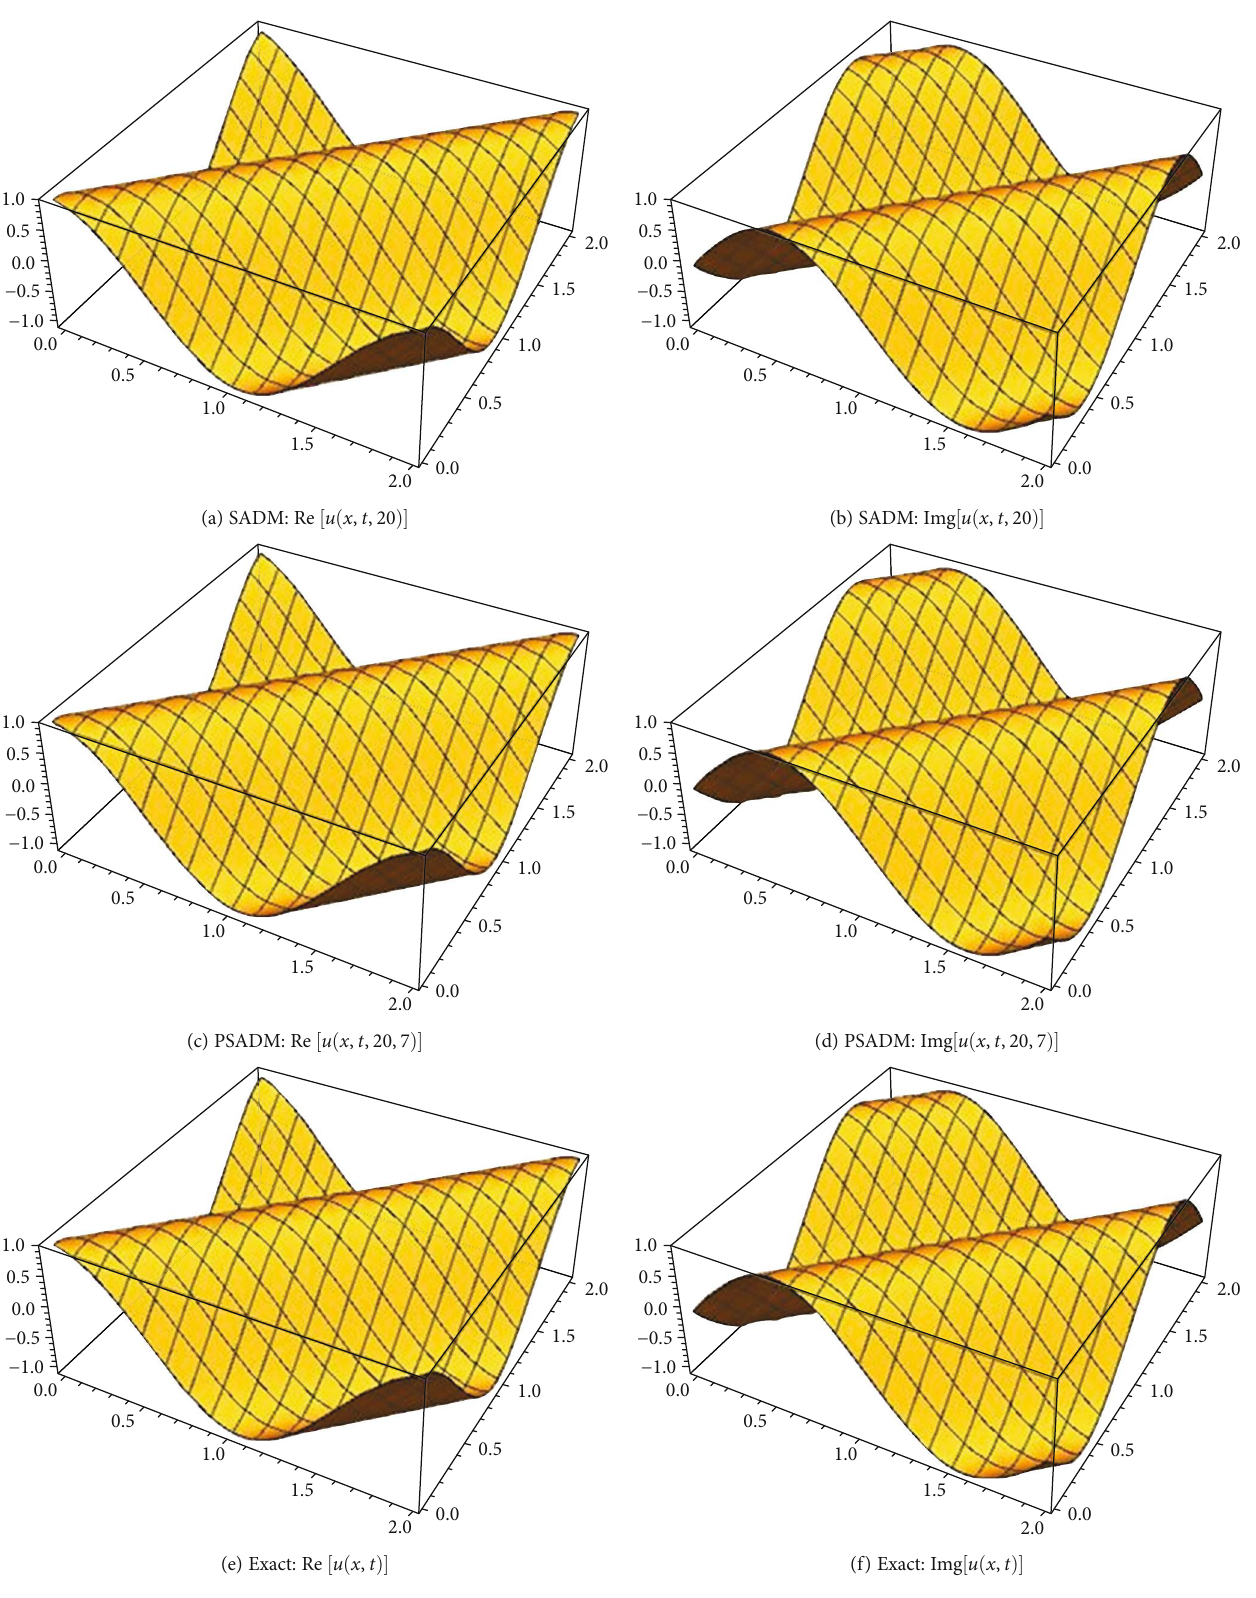
Figure 4: (a – d) SADM and PSADM solutions using 20 terms. (e, f) Exact